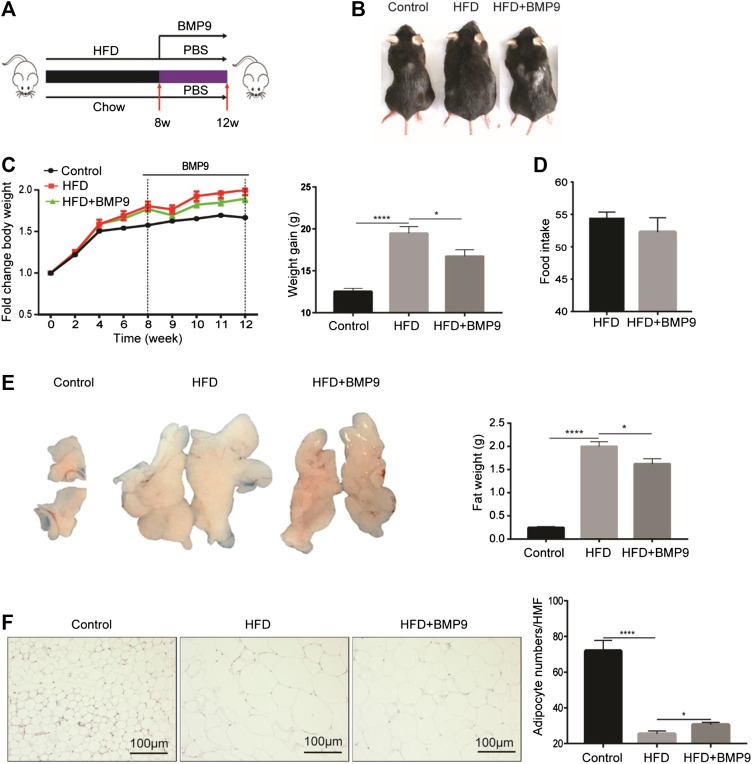
BMP9 reduces HFD-induced obesity in mice (Figure 2C Increasing body weight was changed as weight gain). (A) Experimental flow chart. Male mice were fed an HFD (containing 60% fat) for 8 weeks and administered PBS or recombinant BMP9 200 ng/mice/day via intraperitoneal injection for another 4 weeks. (B) Representative images of mouse in different groups. (C) Body weight was measured at different timepoints. Weight gain was measured from week 0–12. (D) Food intake monitored over the last month. (E) The appearance and weight of VAT. (F) HE staining of VAT (original magnification, ×200) and adipocyte numbers/HMF of VAT in different groups. HMF: High magnification field. The data are presented as the means ± SEM. Control, n = 6; HFD and HFD+BMP9, n = 8 respectively. *p < 0.05, ****p < 0.0001.